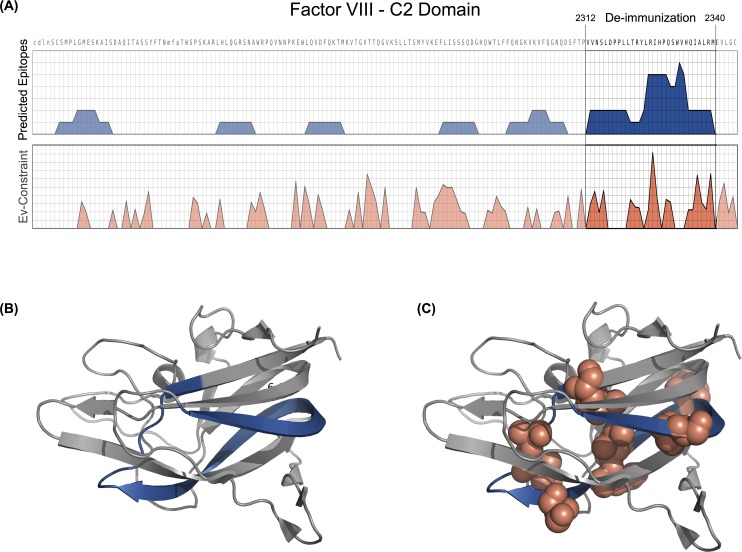
(A) Immunogenicity screening for three DRB1 alleles (DRB1*15:01, DRB1*03:01 and DRB1*07:01) with TEPITOPEpan. All peptides who’s predicted binding affinity fell into the 95% percentile of TEPITOPEpan’s score distributions have been considered epitopes. The blue regions depict the cumulative number of predicted epitopes per position and the orange regions depict the EC cumulative summary scores of top 70 ECs. Six immunogenic regions can be identified based on the in silico screening, with region 2,321 to 2,340 having the highest number of overlapping epitopes (9 out of 16 predicted epitopes) and was thus chosen as de-immunization target. It is comprised of the highest evolutionary coupling pairs. (B) The tertiary structure of Factor VIII’s C2 domain of with highlight immunogenic region selected for de-immunization redesign in blue. (C) The tertiary structure of Factor VIII’s C2 domain with marked top eight EC (red spheres) that coincide with the identified immunogenic region (blue).